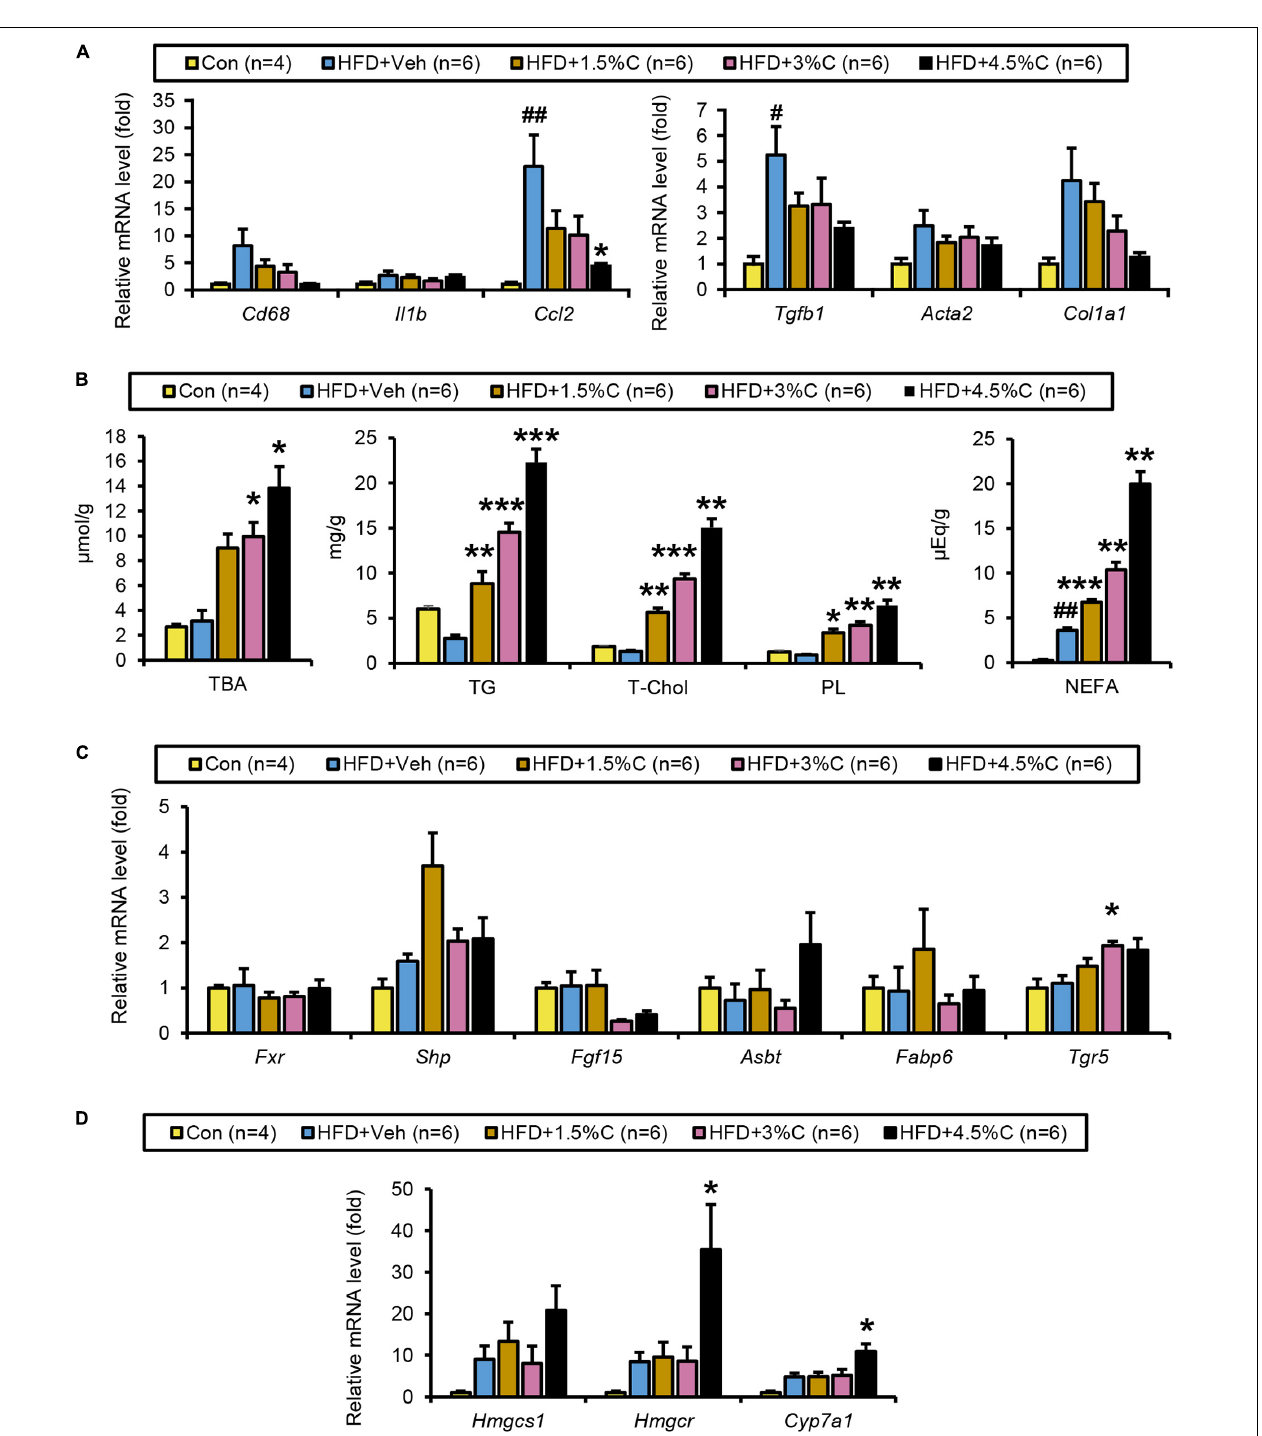
FIGURE 9 | Changes in lipid metabolism after treatment with different dosages of acidic activated charcoal. (A) The mRNA levels of genes related to inflammation ( Cd68, Il1b, and Ccl2 ) and fibrosis ( Tgfb1, Acta2, and Col1a1 ) in the liver. (B) Quantitative analysis of TBA, TG, T-Chol, PL, and NEFA in cecal contents. (C) The mRNA levels of genes related to BA metabolism ( Fxr, Shp, Fgf15, Asbt, Fabp6, and Tgr5 ) in the intestine. (D) The mRNA levels of genes related to cholesterol metabolism ( Hmgcs1, Hmgcr, and Cyp7a1 ) in the liver. Data are expressed as the mean ± SEM. Statistical analysis was performed using a one-way analysis of variance (ANOVA) with the Bonferroni’s correction. * P < 0.05, ** P < 0.01, and *** P < 0.001 between the HFD + Veh group and the HFD + C group. # P < 0.05, and ## P < 0.01 between the HFD + Veh group and the Con group.